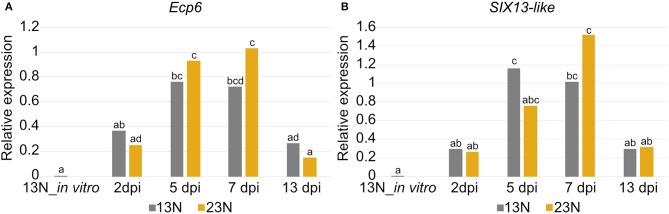
Expression analysis of two candidate effectors from Exserohilum turcicum. Real-time quantitative PCR (RT-qPCR) data are shown for Ecp6
(A) and SIX13-like
(B) from each Exserohilum turcicum race in planta at several time points, as well as in vitro (for race 13N). The y-axis units are the relative expression values (log-transformed mean calibrated normalized relative quantities). Analysis of molecular variance (ANOVA) and the Tukey multiple pairwise comparison was performed to identify pairwise differences in R (R Core Team, 2017) (R Project for Statistical Computing, RRID:SCR_001905). Different lowercase letters indicate significant differences between datasets. Significant pairwise differences were detected in planta for Ecp6
(A) and SIX13-like
(B). The samples collected before inoculation (0 dpi) were excluded as no fungal transcripts were detected.